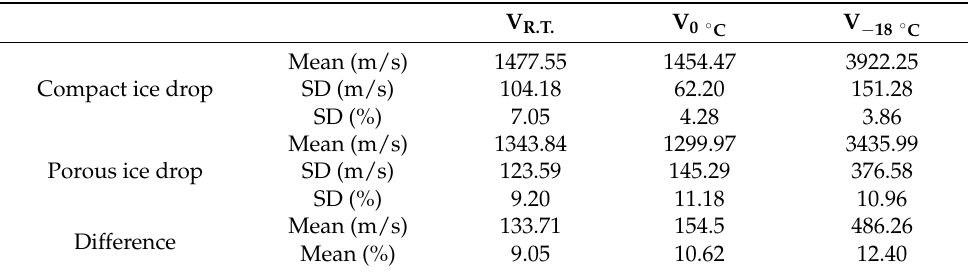
Table 5. Summary of statistical values of the ultrasonic velocity derived from the compact and the porous drop experiments.